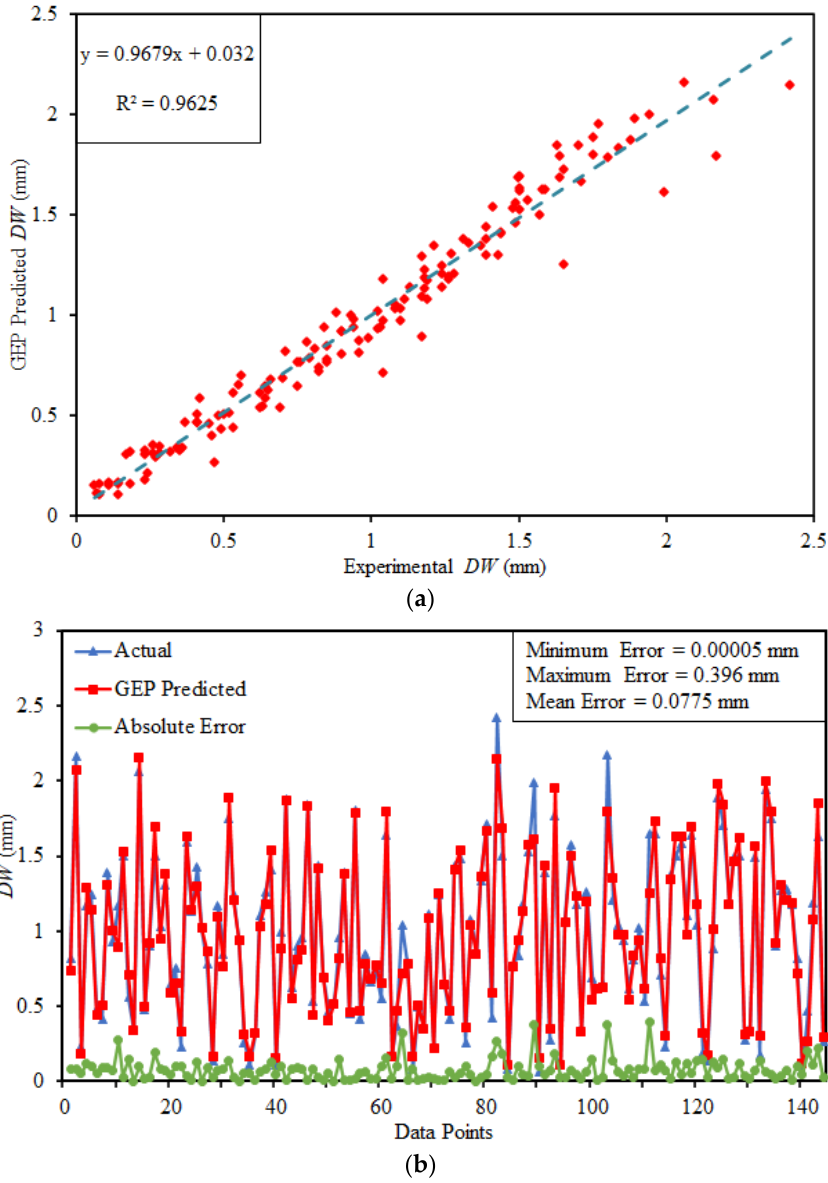
Figure 7. Performance of GEP model ( a ) Regression analysis ( b ) Absolute error plot.